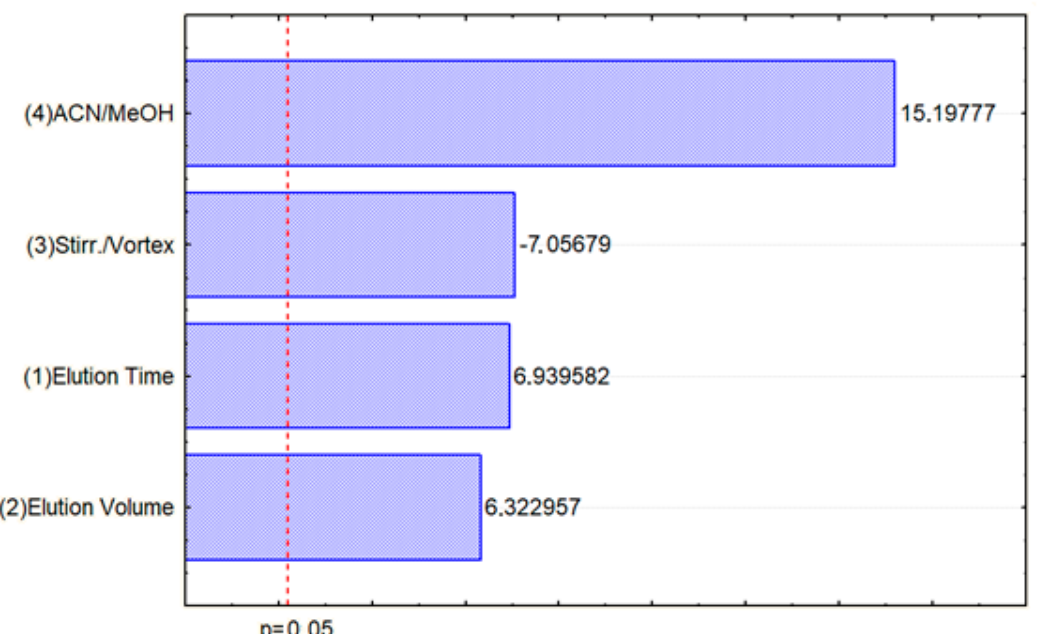
ff ects (2 4 experimental configuration).